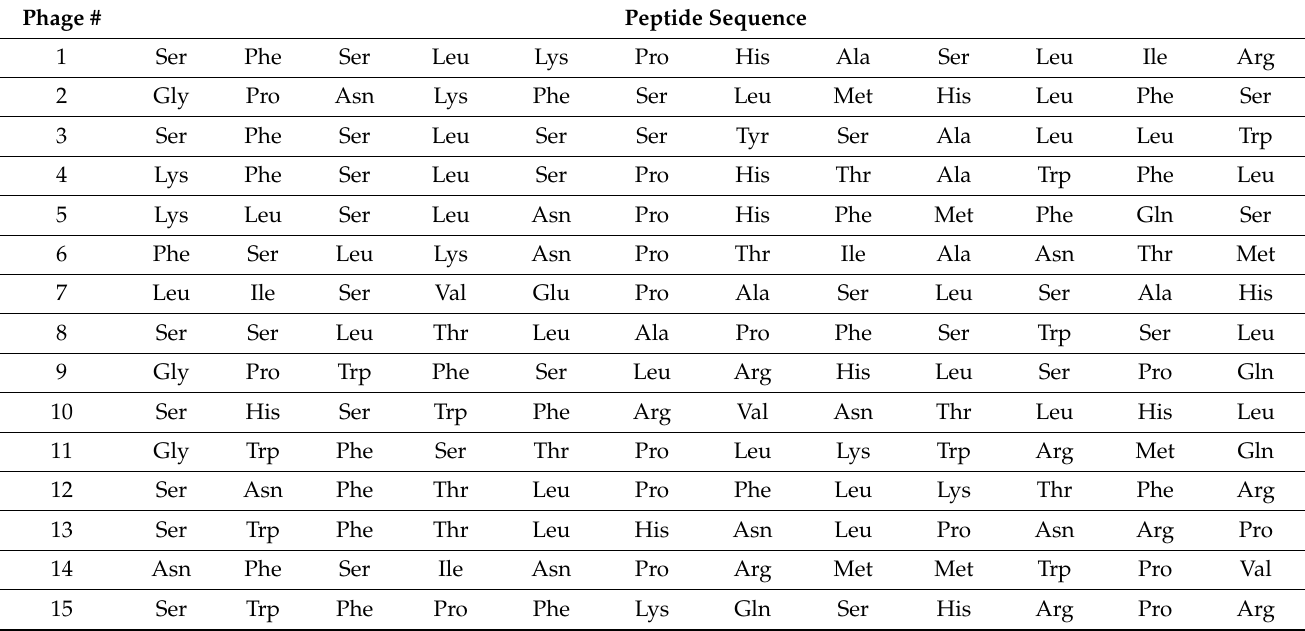
Table 1. Y. pestis F1-antigen-specific phage-display peptide